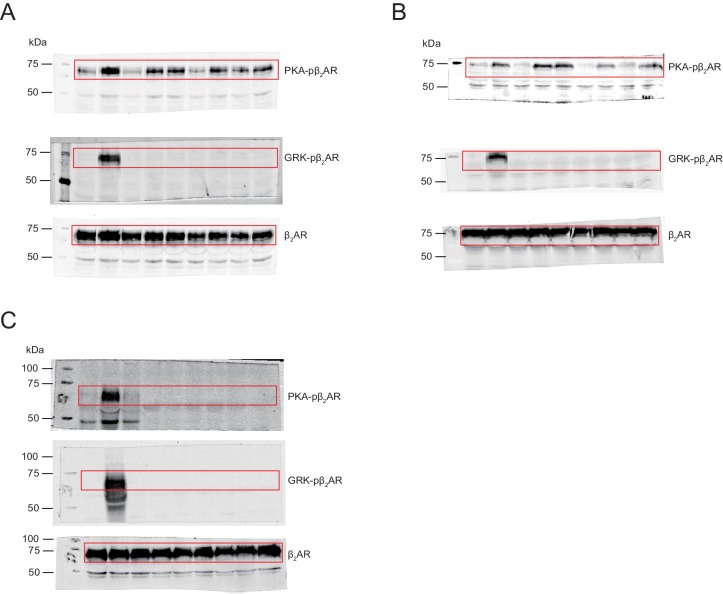
Uncropped blots for Figure 1.(A) Uncropped blots corresponding to Figure 1A. (B) Uncropped blots corresponding to Figure 1B. (C) Uncropped blots corresponding to Figure 1C. Red box indicates the crop region displayed in main figure.